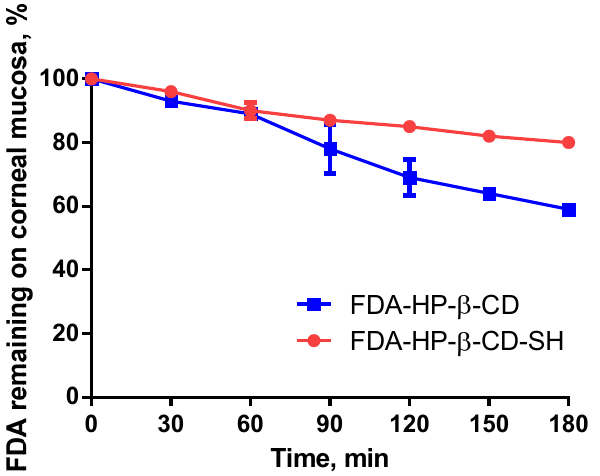
Figure 3. Time course of percentage of FDA incorporated in HP- β -SH or HP- β -CD remaining on corneal mucosa continuously rinsed with 100 mM phosphate buffer at 37 ◦ C and 100% relative humidity. Each point is the mean ± SD of three values.